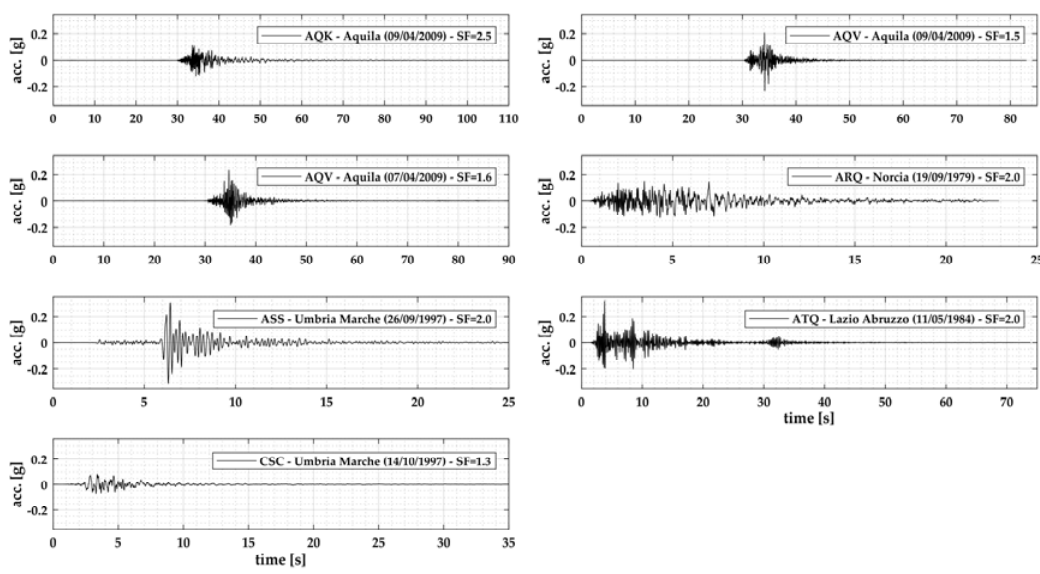
Figure 7. Time histories of the scaled accelerograms for an RP of 500 years.